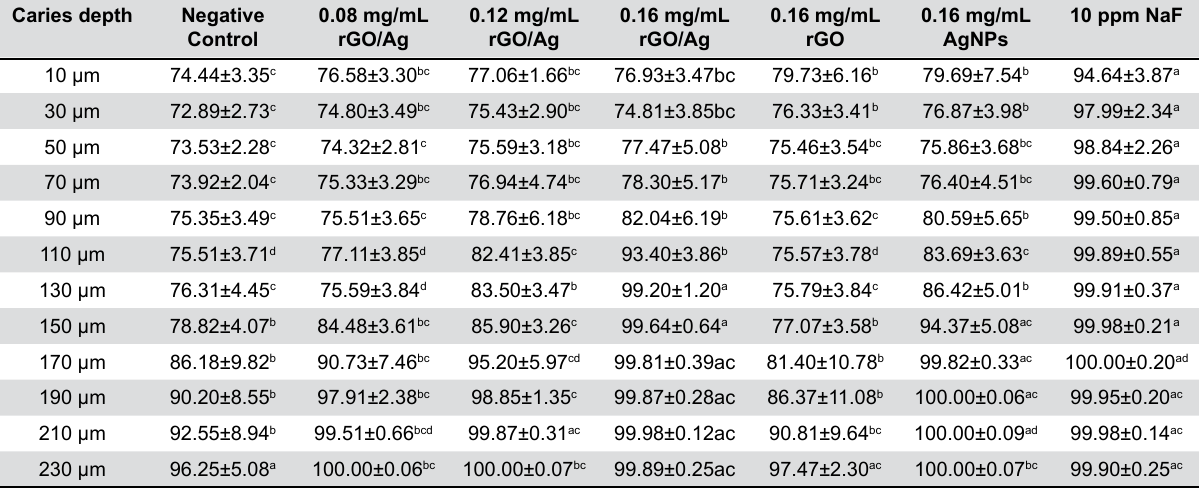
Table 1- Relative optical density (ROD) of artificial enamel lesions treated with rGO/AG, GO and AgNPs at different depths of tooth specimens (n=10)